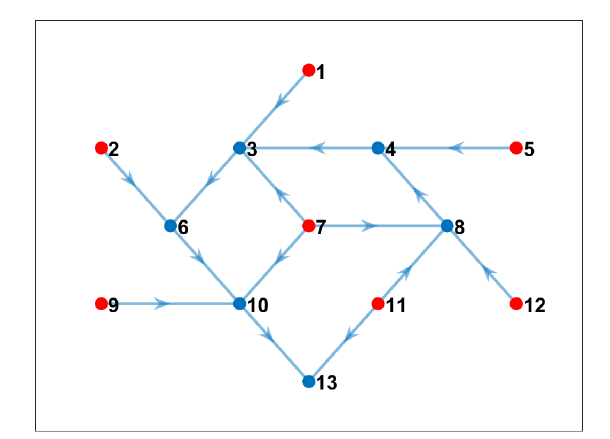
Figure 11. Communication pattern using the proposed model when we considered variable bandwidth (blue nodes are nodes that computed cross-correlation; red nodes only sent data to the corresponding network). Nodes that computed